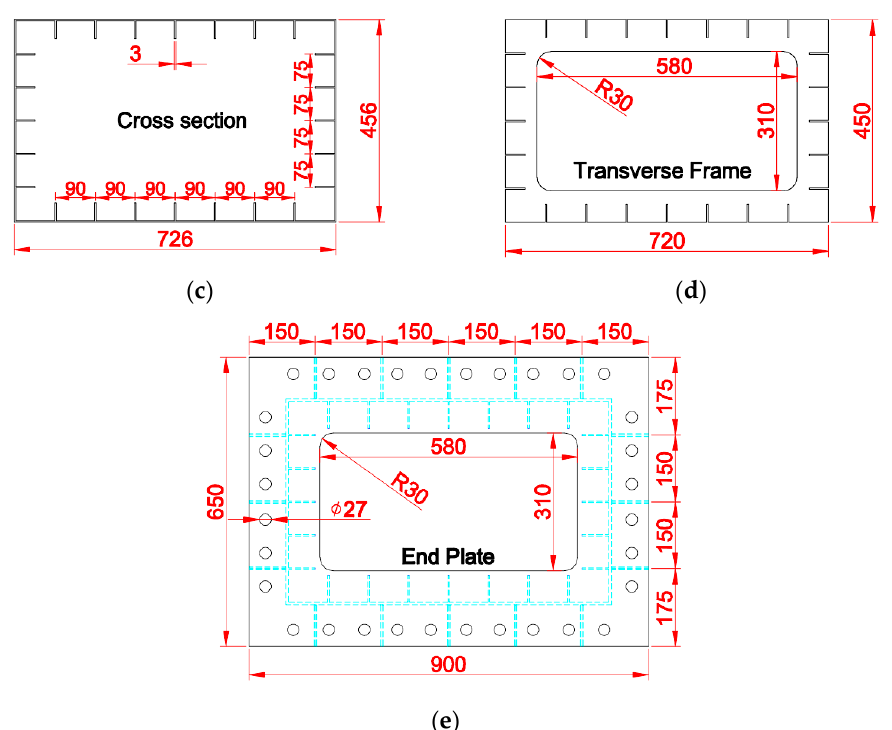
Figure 1. Dimensions of the box girder: ( a ) deck plan; ( b ) side plan and longitudinal stiffener; ( c ) cross section; ( d ) transverse frame; ( e ) end plate (unit: mm).